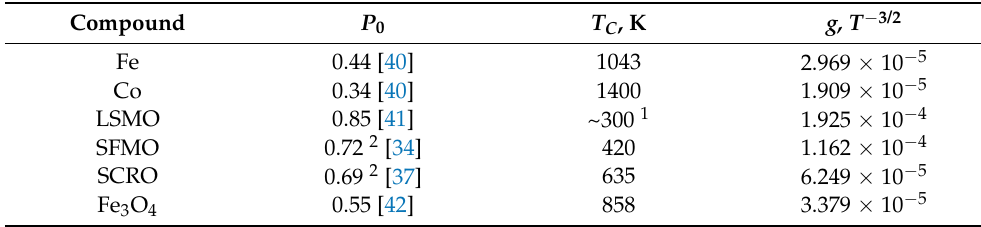
Table 1. Low-temperature spin polarization, Curie temperature, and Bloch’s T 3/2 law coefficient of ferromagnetic metals and ferrimagnetic